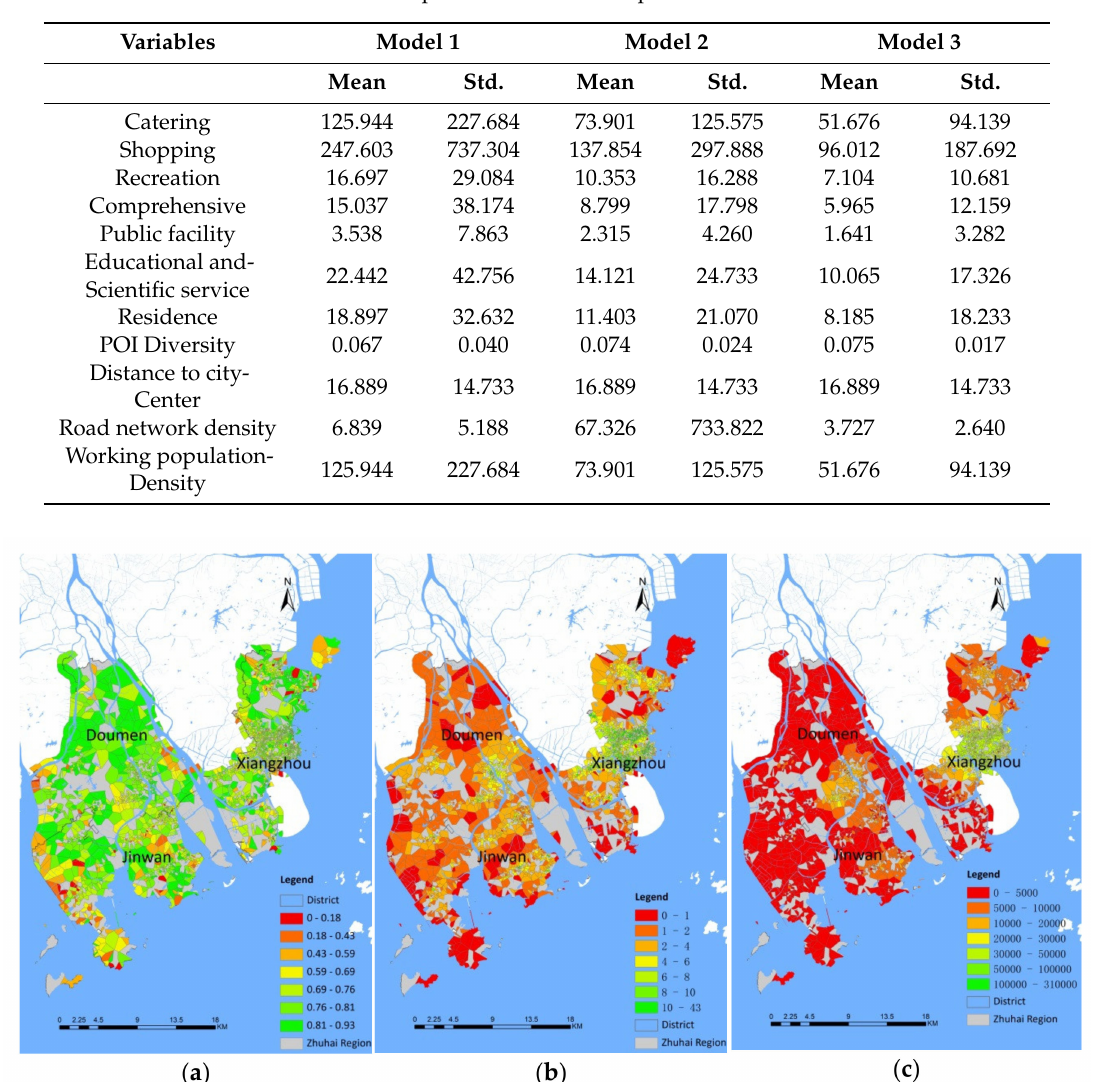
Figure 6. The distribution of three variables in Commuting activity space. ( a ) POI diversity; ( b ) road density (km / km 2 ); ( c ) working population density ( / km 2